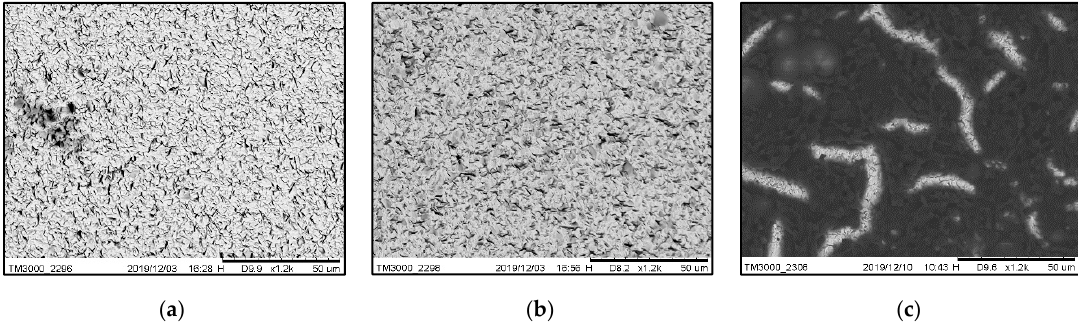
Figure 4. SEM image of the quartz crystal coated with the ( a ) branched PEI layer, ( b ) linear PEI layer